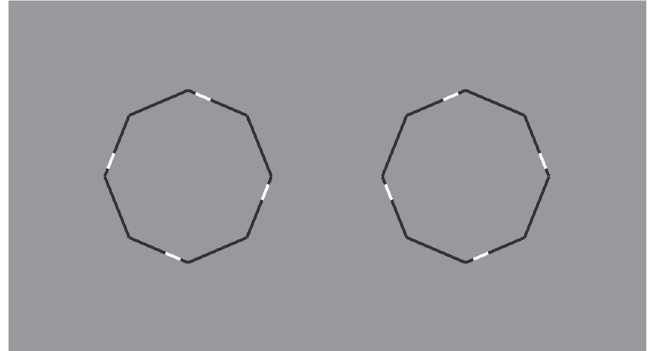
Figure 18. The octagons appear irregular and oriented in opposite directions.